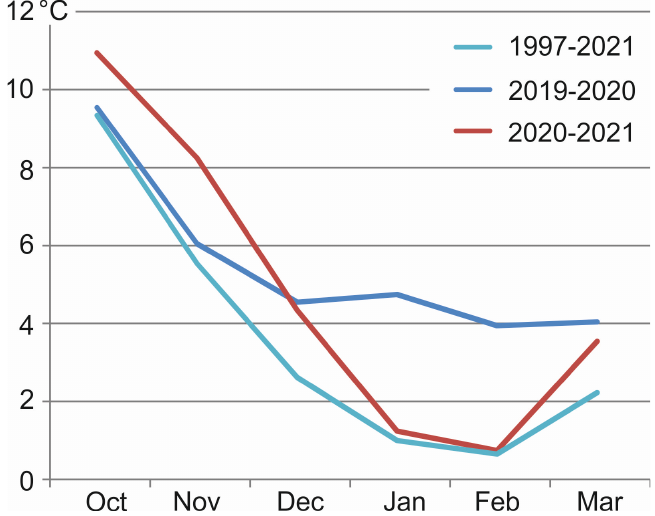
Figure 11. Mean monthly air temperatures in winter 2019/2020 and 2020/2021 compared with the multi ‐ annual period, Fårösund (Own elaboration based on SMHI.se).